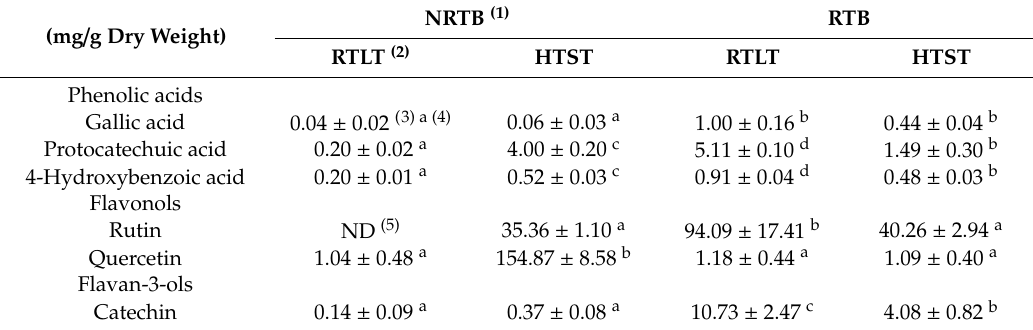
Table 2. Phenolic compound contents (mg / g dry weight) of TB teas.